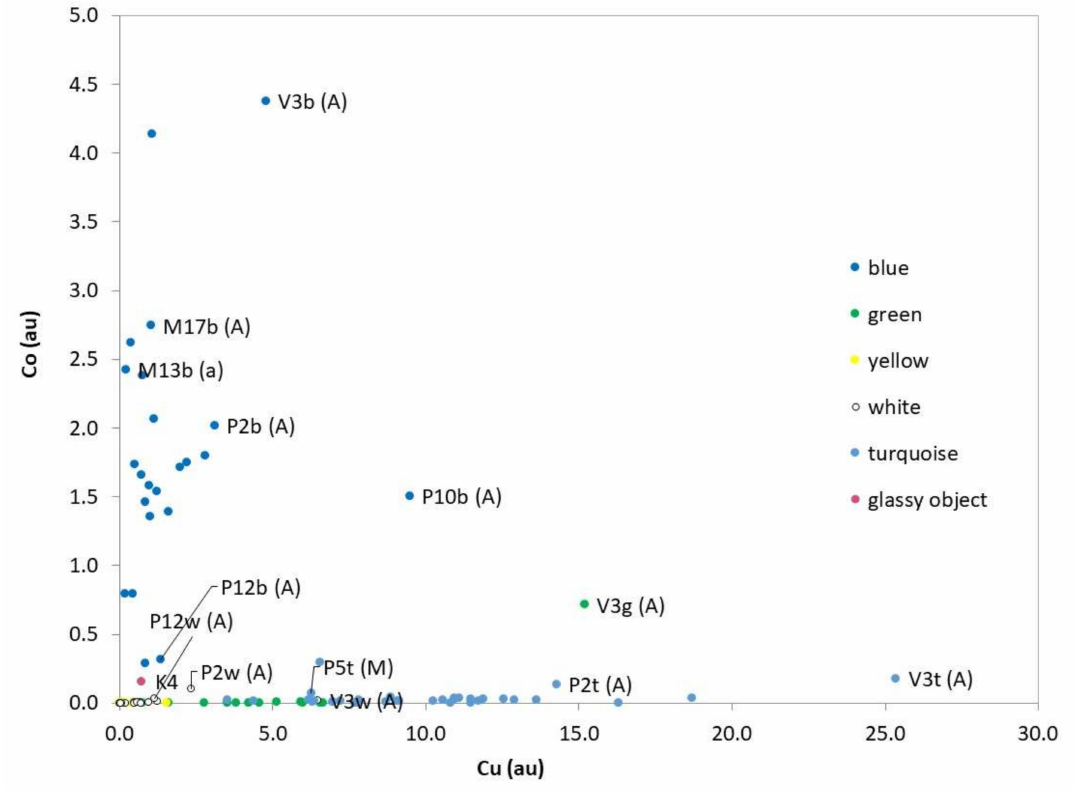
Figure 7. Scatter plot of cobalt against copper as counts obtained by XRF in arbitrary units.